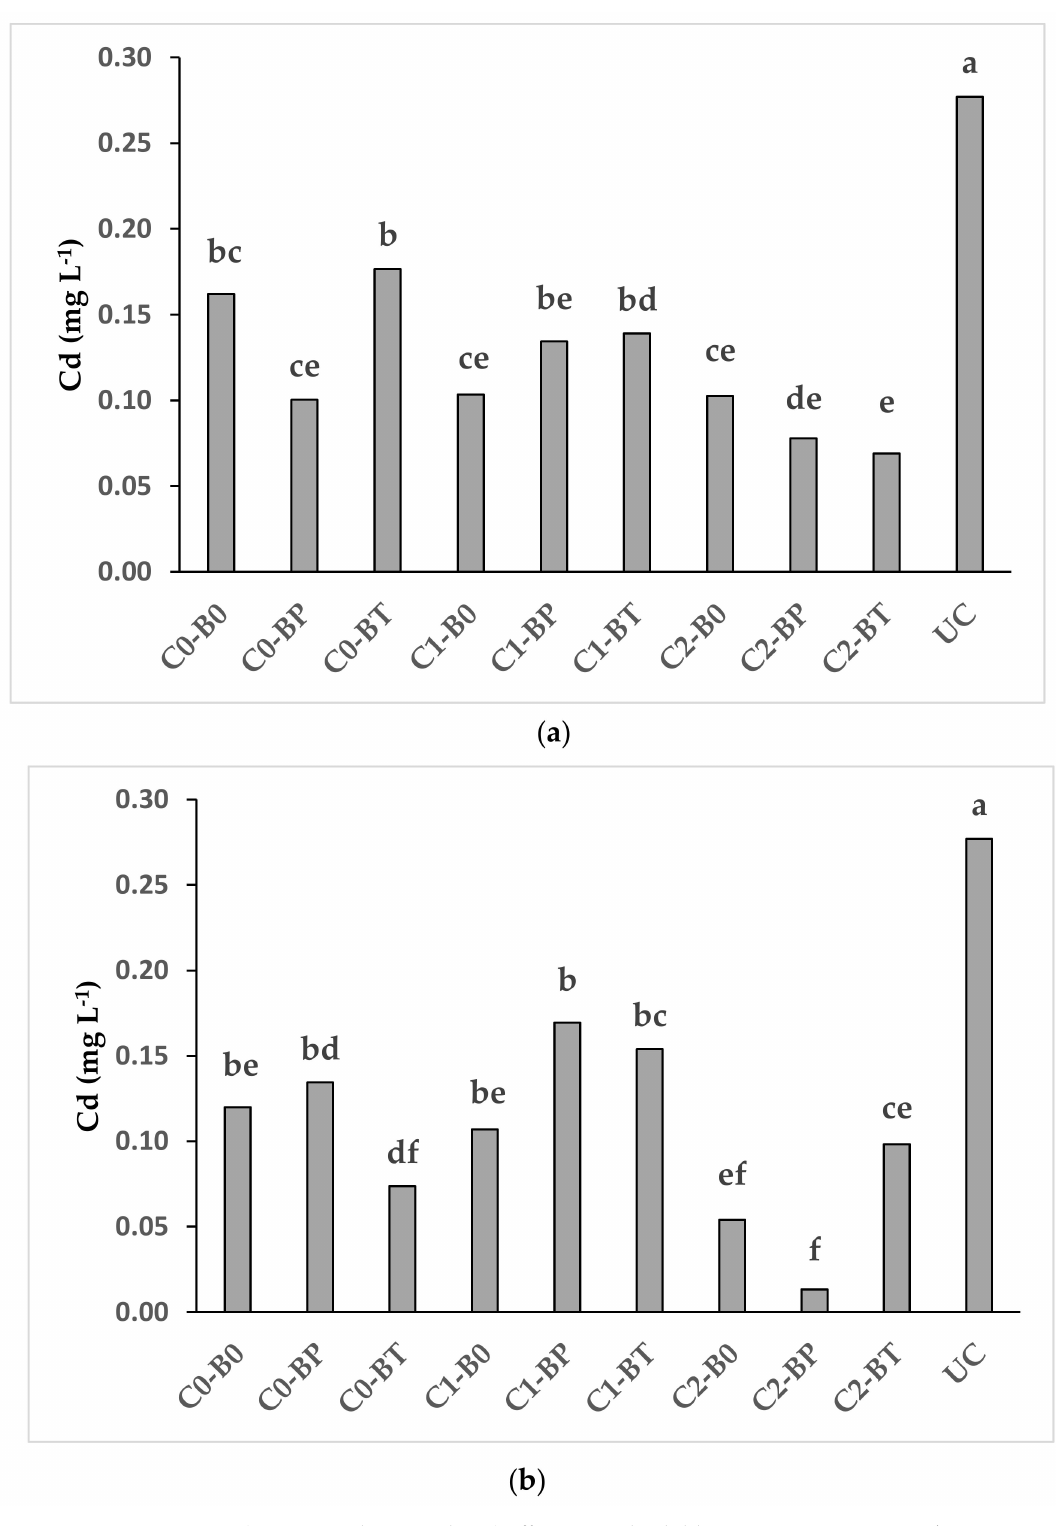
Figure 2. Interaction (compost × biostimulants) e ff ects on Cd soluble concentrations in D. glomerata L. ( a ) and in a mixed stand of F. arundinacea Shreb. , L. perenne L. and P. pratensis L. ( b ) C0 = no compost, C1 = 0.7%, C2 = 1.4%; B0 = no biostimulants, BP = Panoramix, BT = Trianum-P; UC = non-planted and untreated soil. Bars (means) marked with the same letter do not di ff er significantly according to the LSD test ( p <